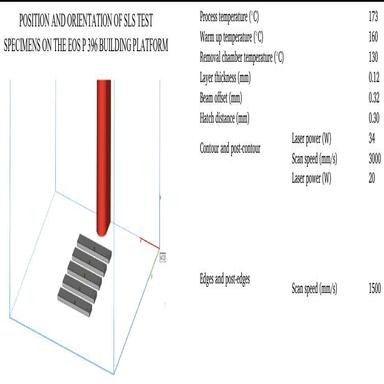
Experimental setup of DCB evidencing crack propagation.